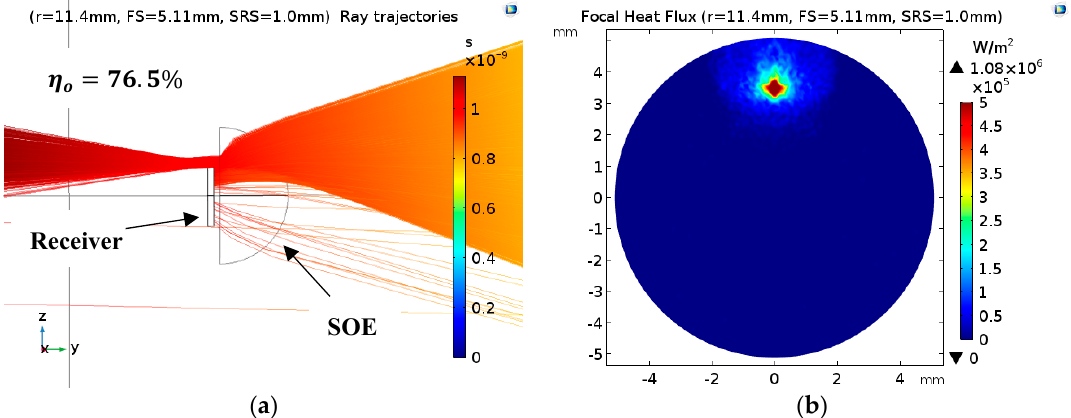
Figure 10. For Case 2: ( a ) ray trajectories through the optimum SOE parameters of this work at the acceptance angle of 1.31° and ( b ) the receiver’s irradiance distribution in W/m 2 at the acceptance angle of 1.31°.